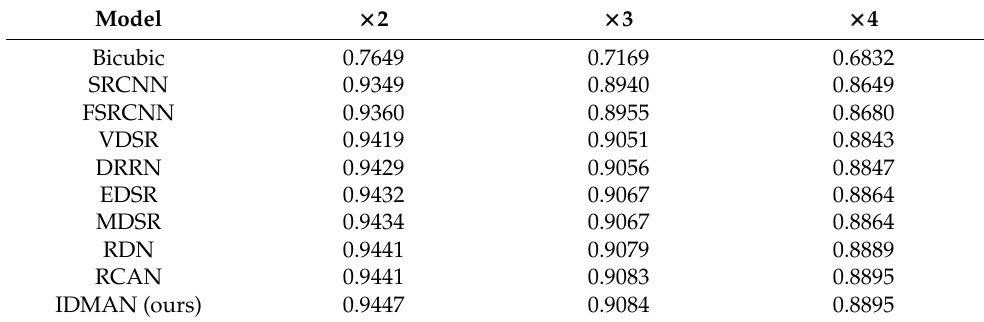
Table 6. The average SSIM results of different algorithms on the DeepLesion testing set with different scaling